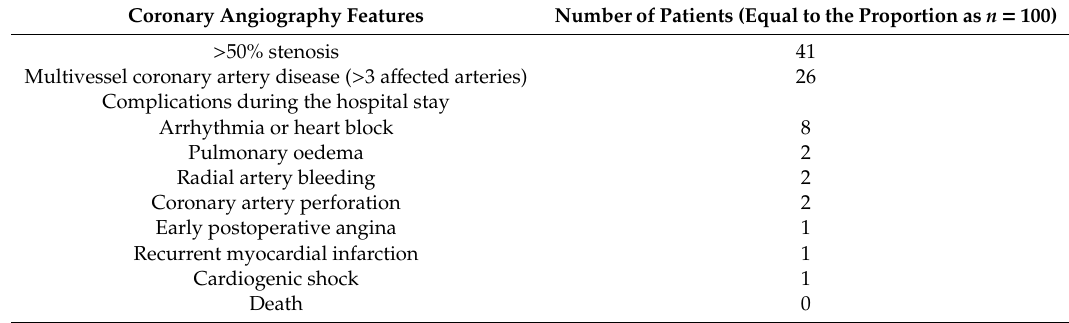
Table 3. Coronary angiography features and in-hospital complications in patients with ST-segment elevation myocardial infarction with preserved ejection fraction